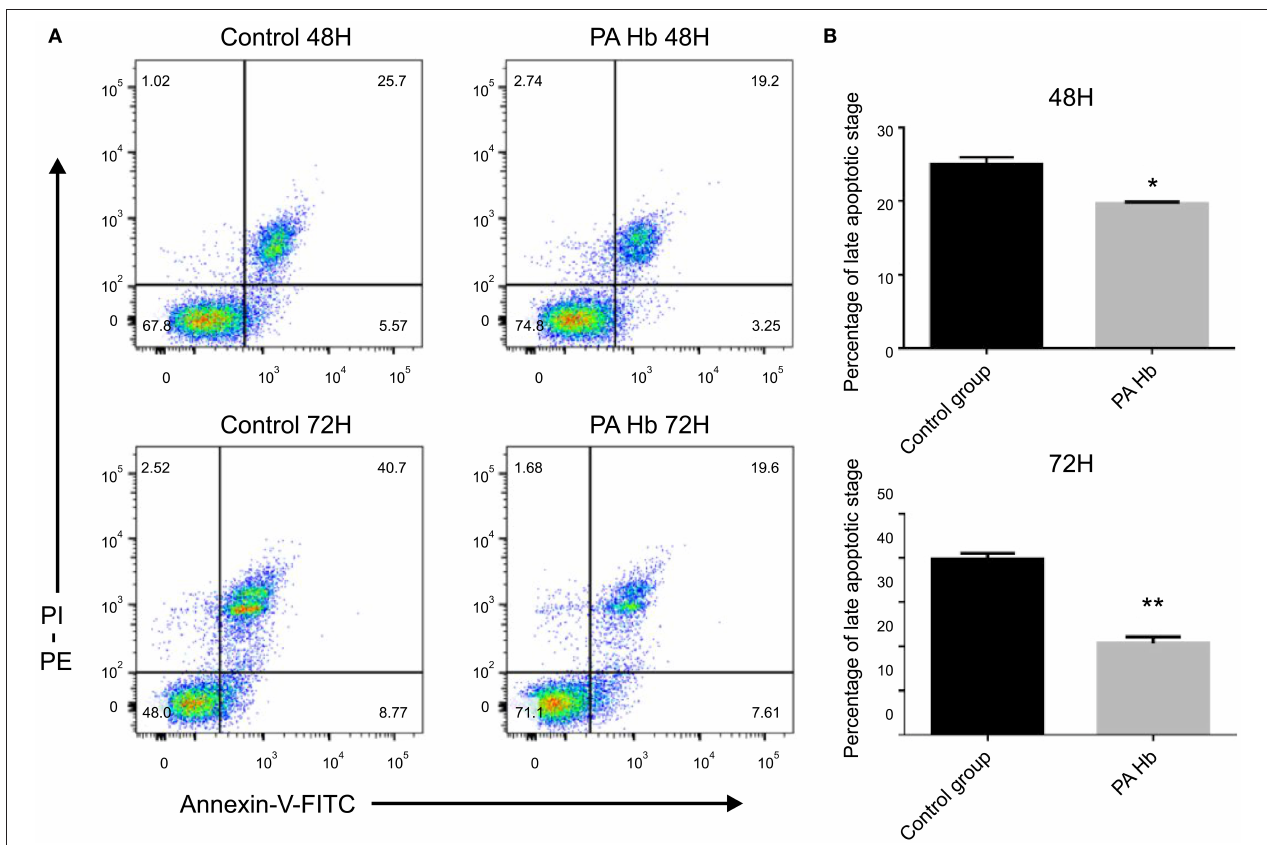
FIGURE 4 | PA hemoglobin decreases the rate of apoptosis. Cells were treated with and without PA Hb for 48 or 72h at the concentration of 0.625 µ g/mL, and analyzed by Annexin-V-FITC/PI staining. Apoptosis rate was presented as a percentage of total nucleic number. (A) Representative dot blot image of stained cells. (B) Statistical analysis of the late apoptotic cells proportion. ** p < 0.01; * p < 0.05. Results are expressed as means ± SEM. Statistical analysis was performed using the Student’s t -test and the control group was used for